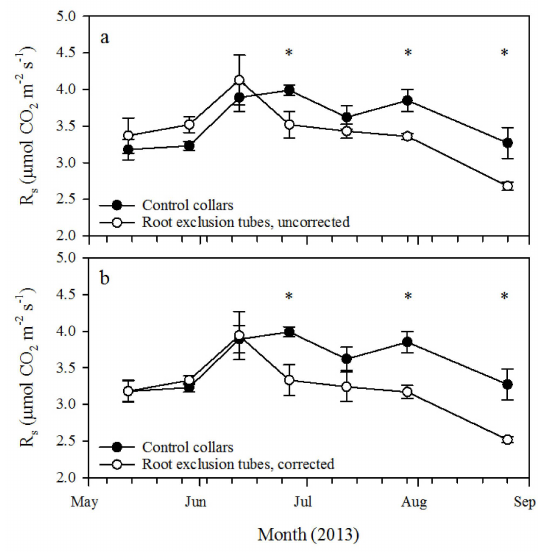
Figure 3. Soil respiration (R s ) from control collar and root exclusion tubes by date measured in three 26-year-old longleaf pine ( Pinus palustris Mill.) stands ( a ) uncorrected and ( b ) corrected by pretreatment R s variation between collar pairs. Note: Asterisks (*) denote significant treatment effects at α = 0.05. Error bars are ˘ 1 SE (standard